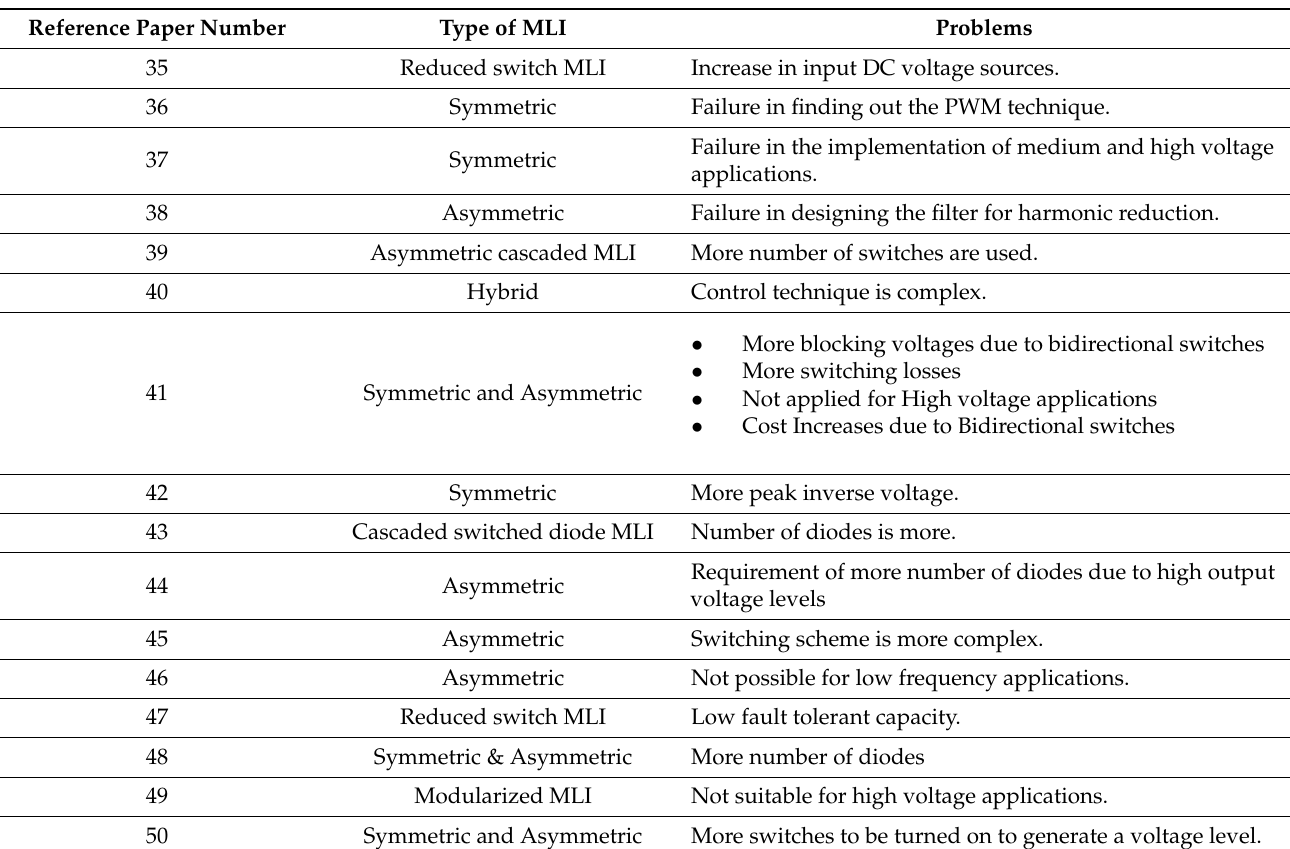
Table 3. Issues in